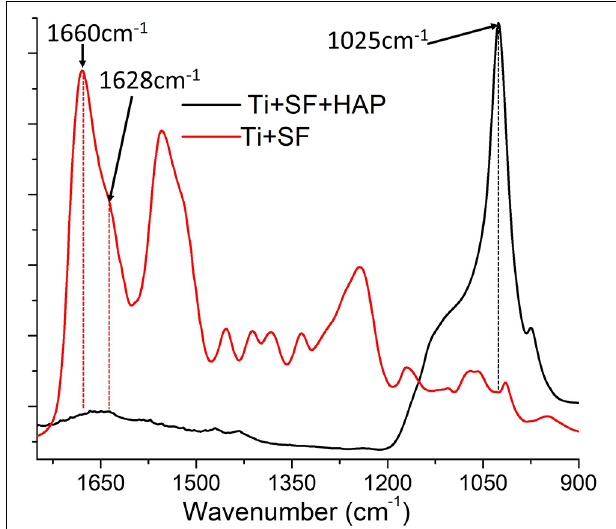
FIGURE 2 | ATR–FTIR spectra of Ti + SF and Ti + SF + HAP